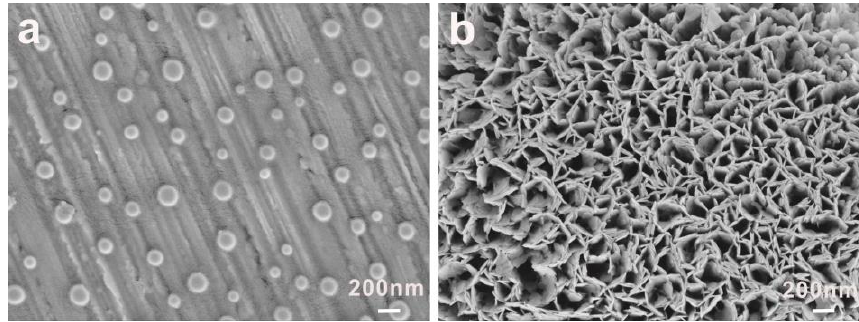
Figure 3. SEM images of 2 g L -1 PEG-acrylic rosin polymer at ( a ) 25 °C and ( b ) 85 °C.